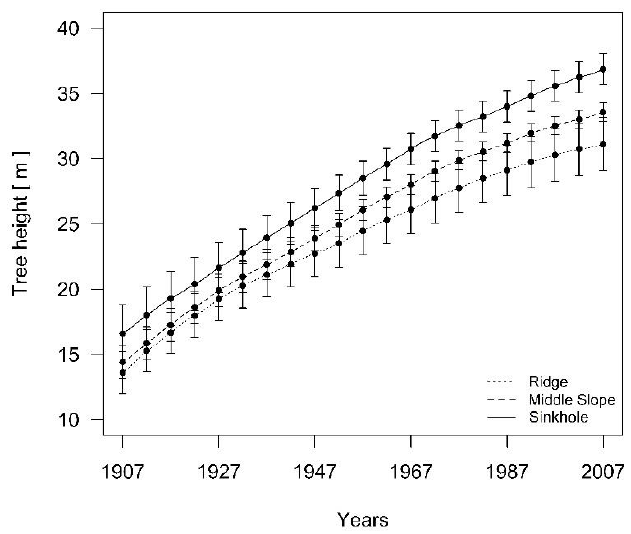
Figure 8. The development of height differences for 3 silver fir tree groups after the period of suppressed fir growth. The 95% confidence interval is shown.